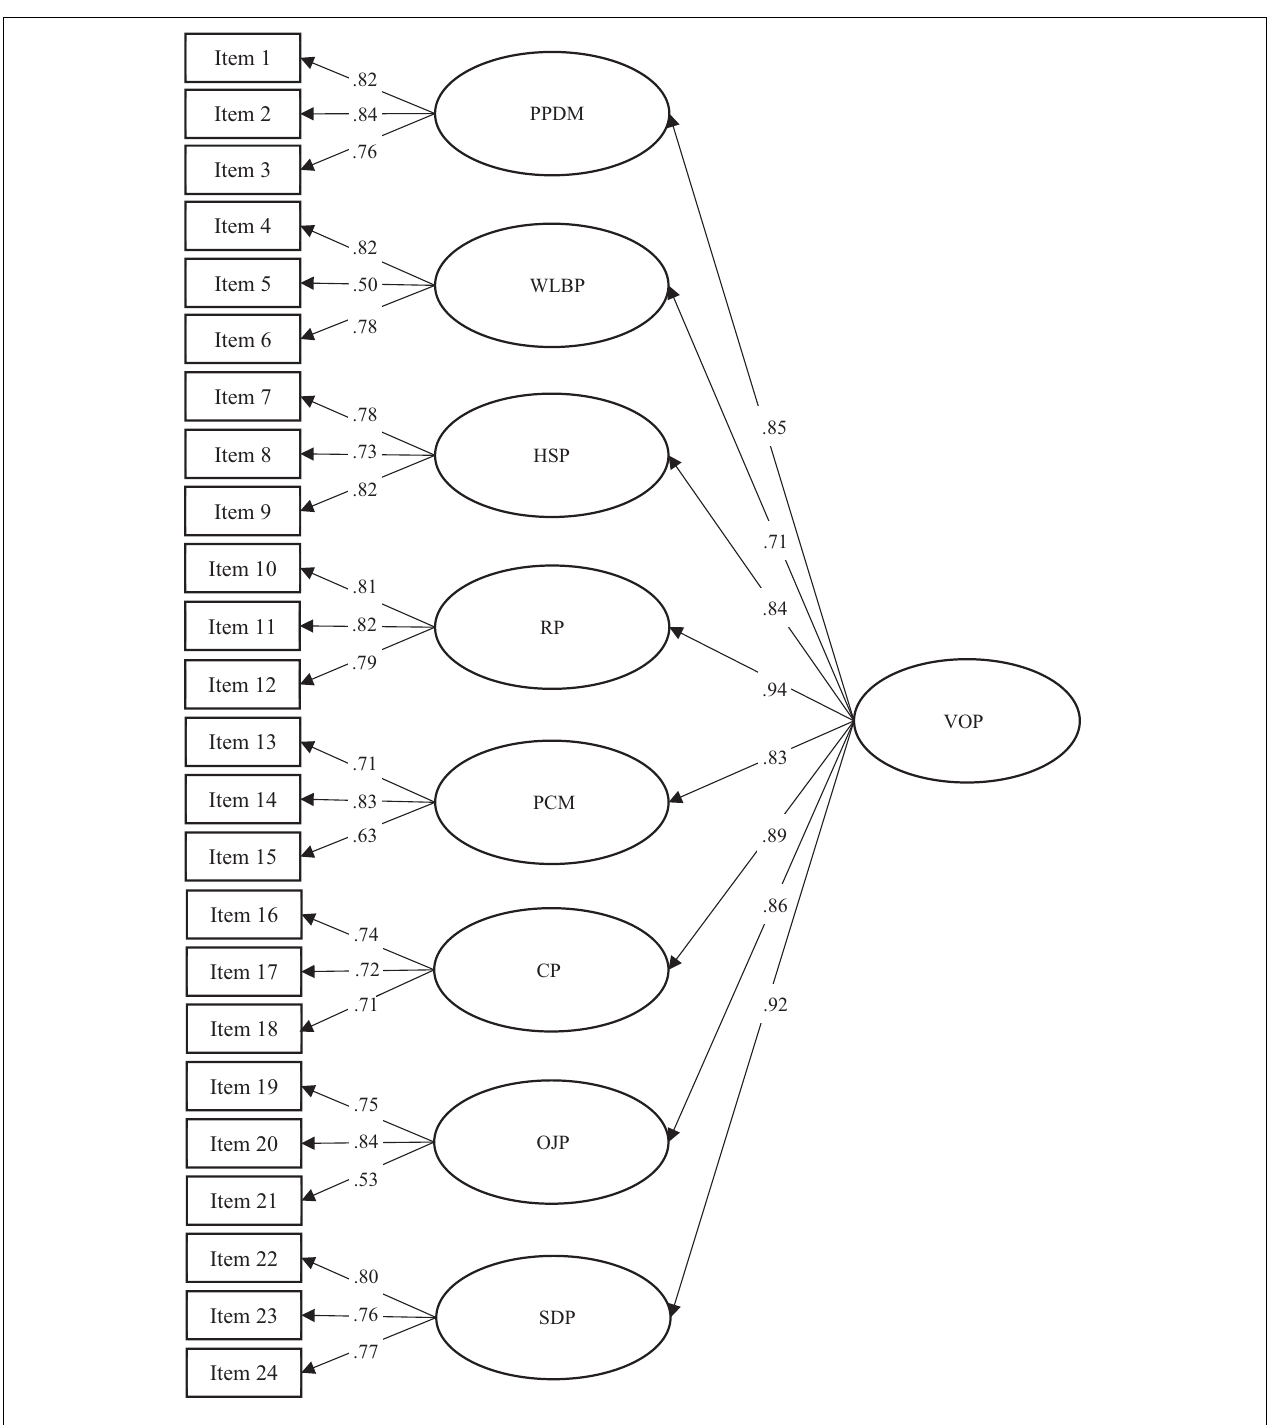
FIGURE 1 | CFA with second-order factor model (Study 3). All correlations are significant at p < 0.01.